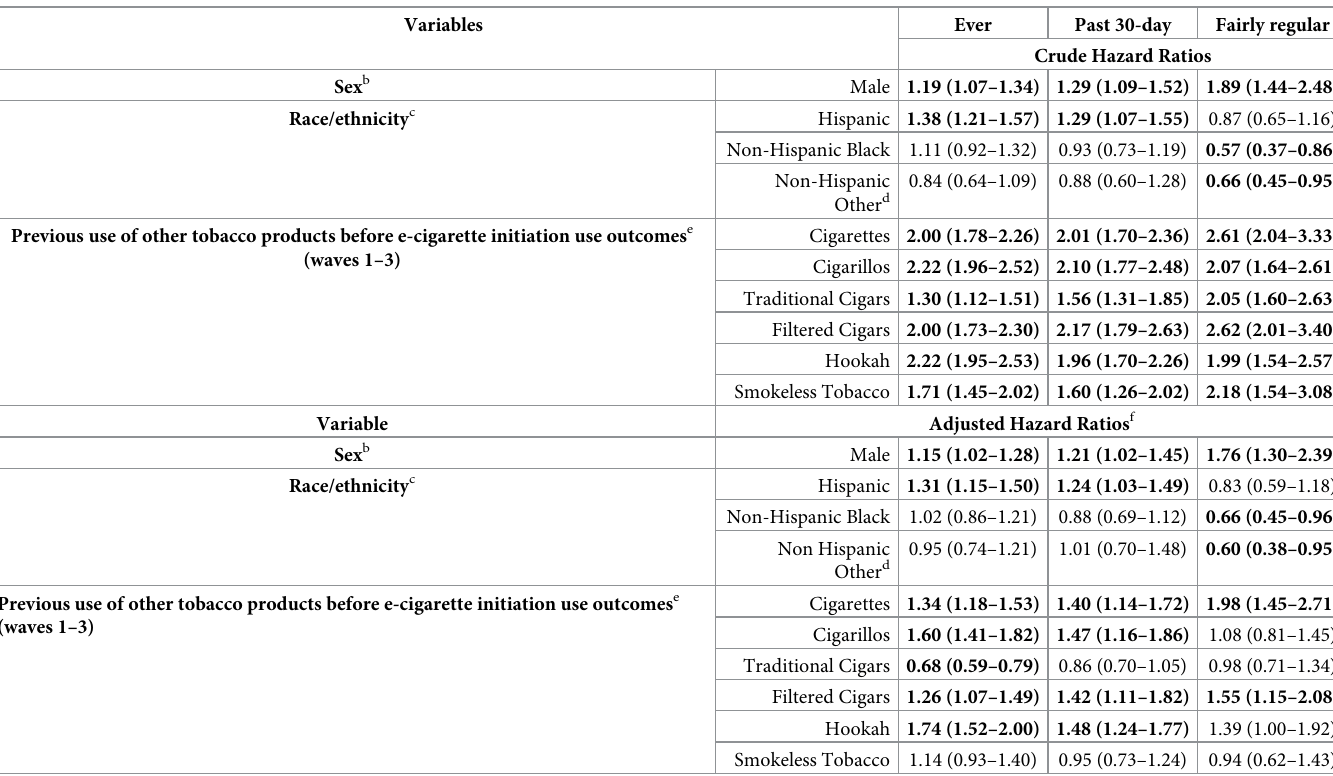
Table 3. Crude and adjusted hazard ratios (95% confidence intervals) for the age of e-cigarette initiation outcomes among PATH a young adults